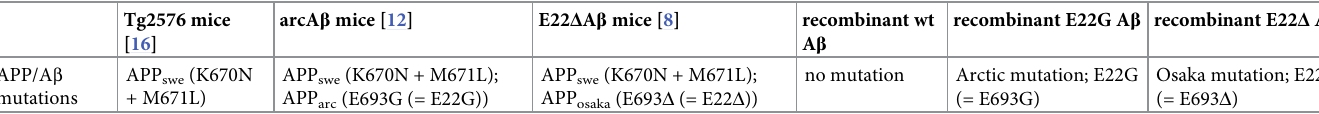
Table 1. APP/A β mutants used in this